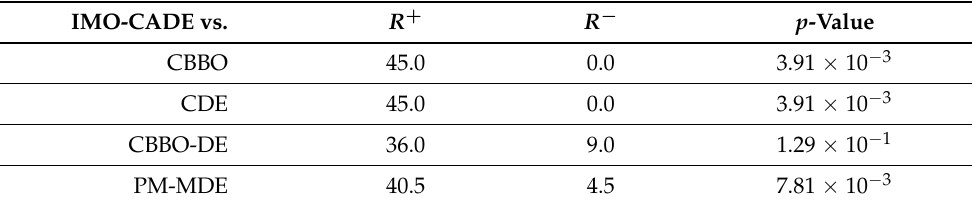
Table 4. Results obtained by the Wilcoxon test for IMO-CADE vs. other methods with reported results under i.i.d. observations.